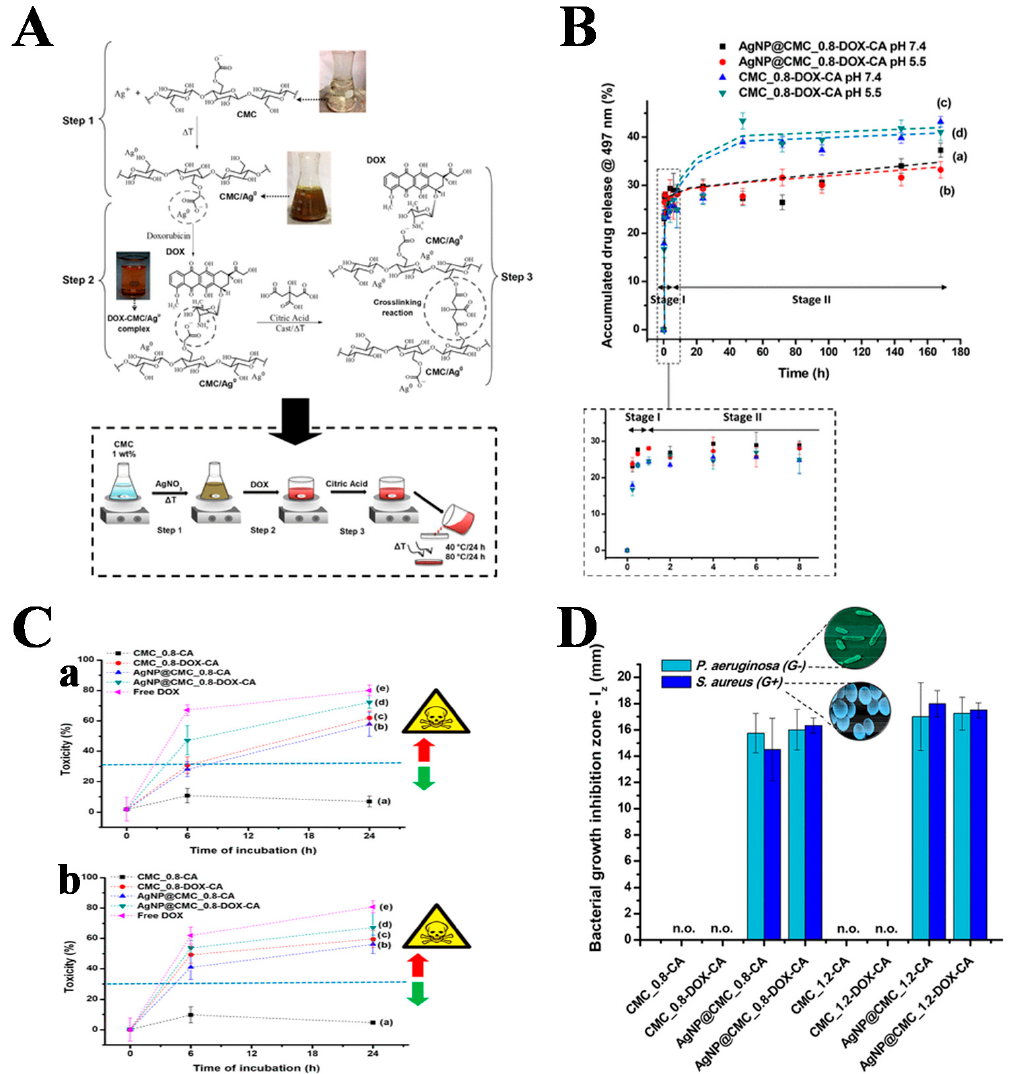
Figure 9. ( A ) Schematic illustration (chemistry perspective) of the complete process of synthesis of the hybrid hydrogel membranes. ( B ) In vitro release of DOX from hydrogels as a function of pH. ( C ) In vitro cytotoxicity based on the MTT assay of ( a ) HEK 293T and ( b ) A375 cell lines after incubation with hydrogels and hybrids. ( D ) Evaluation of resistance/sensitivity of Gram-positive ( S. aureus ) and Gram-negative ( P. aeruginosa ) bacteria toward cross-linked hydrogels: effect of AgNPs, DOX, and AgNPs + DOX (n.o. = not observed). Reprinted with permission from Ref. [155]. Copyright 2019, American Chemical